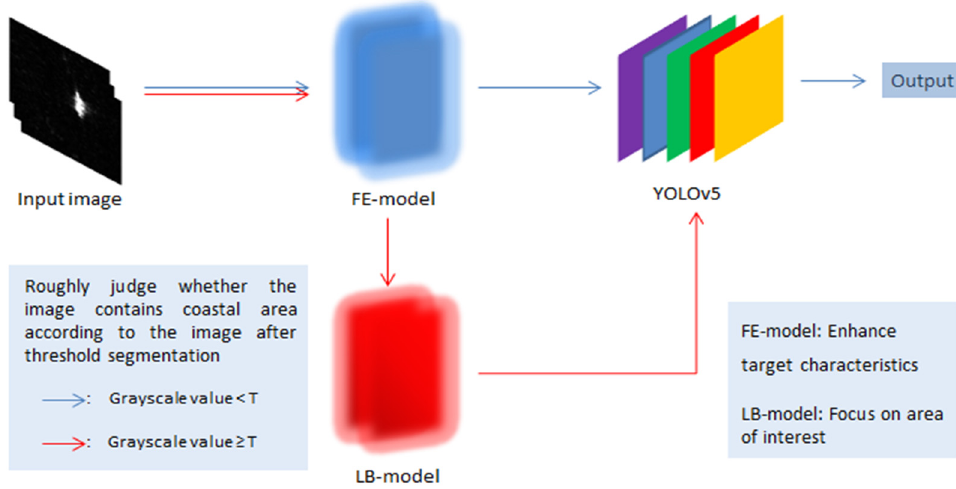
Figure 1. Ship inspection network